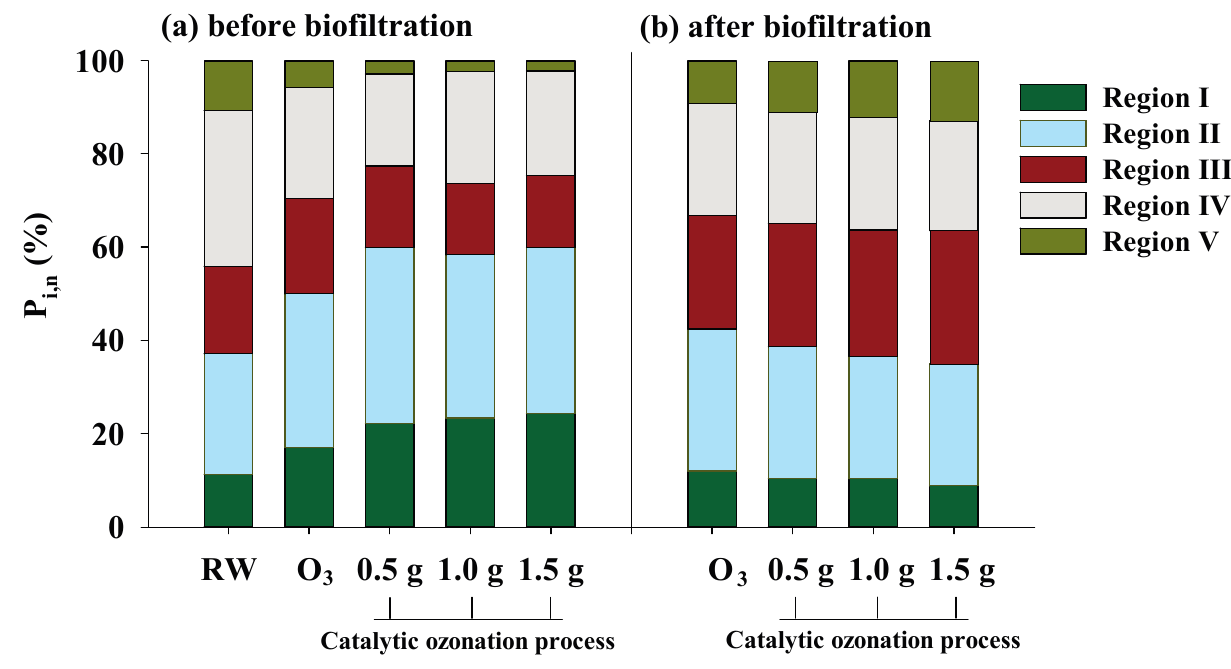
Figure. 4. Changes in the P of the DOM samples after catalytic ozonation and catalytic i,n ozonation/biofiltration (RW: raw water; O , ozonation; ozone concentration: 2.5 mg·L − 1 ; 3 gas flow: 50 mL·min − 1